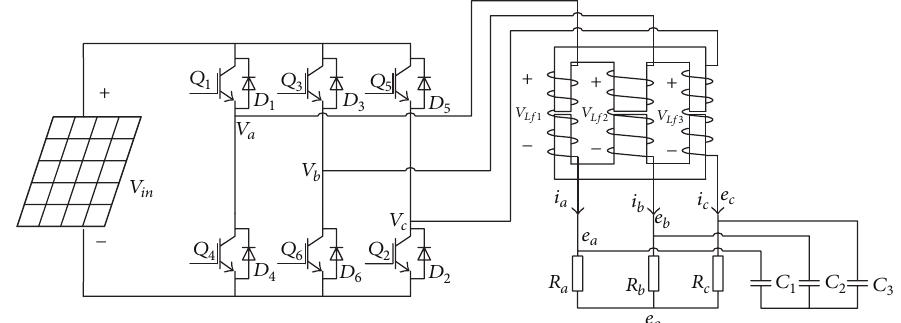
Figure 6: The three-phase integrated filter inductors with three magnetic limbs in three-phase inverter.